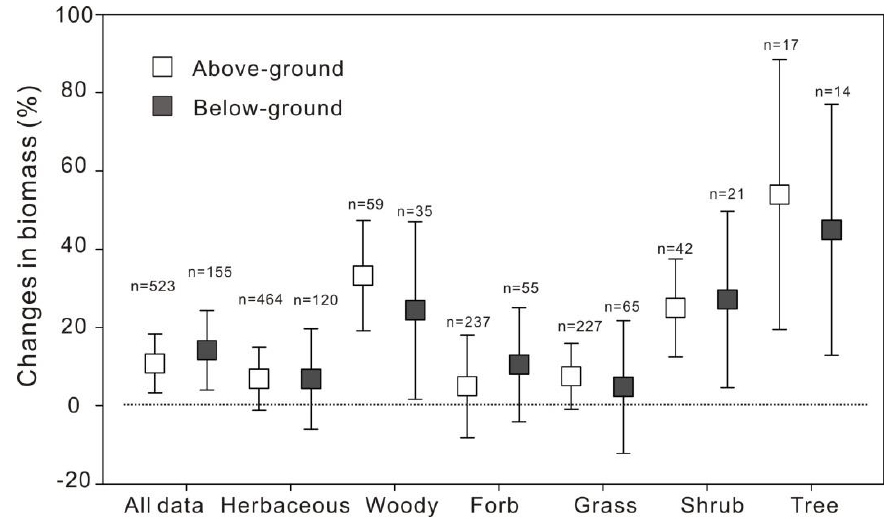
Figure 2. Responses of plant biomass (inverse-variance weights), above-ground biomass (AGB), and below-ground biomass (BGB), to warming as a percentage change relative to the control (%) across plant functional types (PFTs). Changes in biomass values are means ± 95% CI and the number of observations ( n ) are shown near the bar.